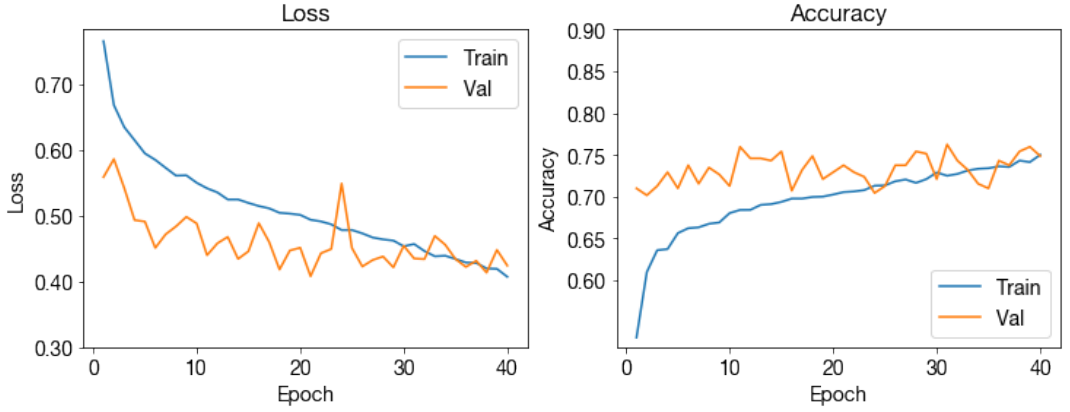
Figure A17. 3D CNN loss and accuracy across training epochs.